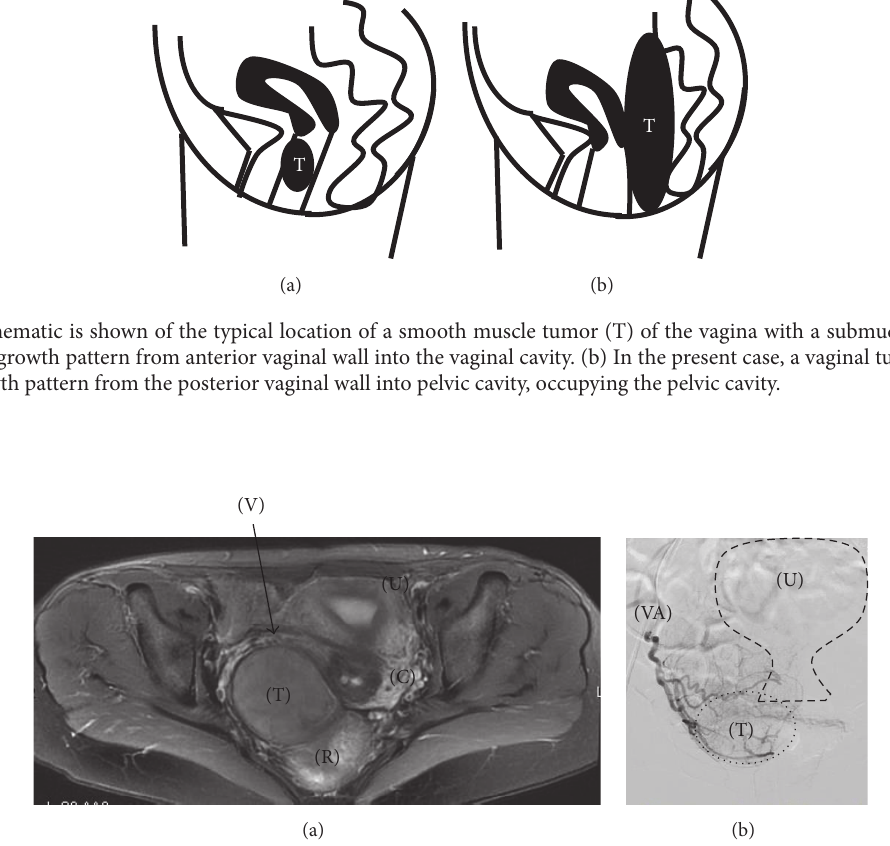
Figure 2: (a) Contrast enhanced MRI radiological analysis. A transverse section shows the tumor (T) anteriorly compressing the uterus corpus (U), cervix (C), and vaginal canal (V), posteriorly compressing the rectum (R). (b) Angiography frontal section image showing that the tumor (T) was nourished from the vaginal artery (VA) and the uterus corpus (U).